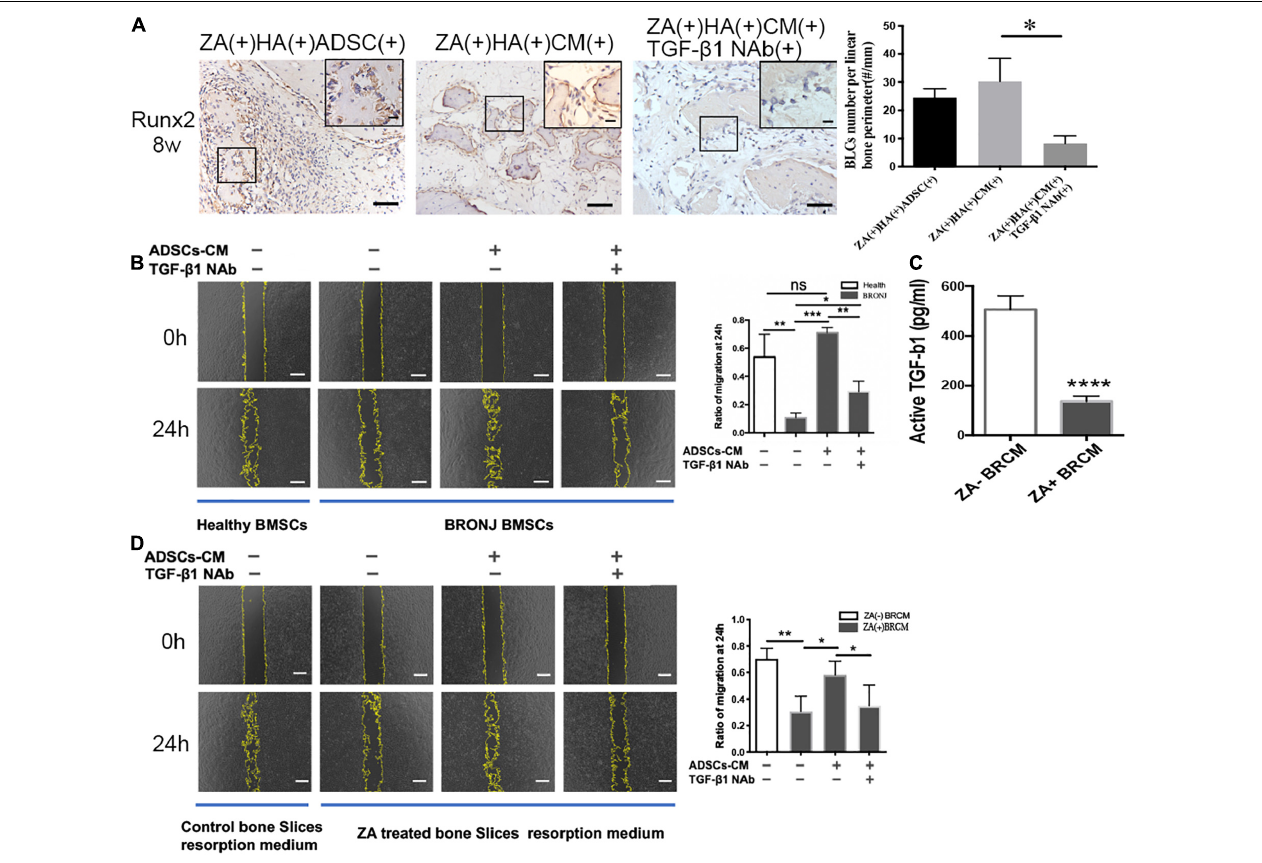
FIGURE 4 | Inhibition of TGF- β 1 attenuates Runx2-positive BLCs and BMSCs migration. (A) BLCs were evaluated by IHC of Runx-2 and quantification in alveolar sockets 8 weeks after tooth extraction in each group. The inset shows the boxed region magnified. Bar: 50 µ m, bar of magnified image: 20 µ m. (B) Migration of BMSCs from healthy individuals or BRONJ patients treated with ADSCs-CM without/with TGF- β 1 NAb and its quantification. Bar: 400 µ m. (C) TGF- β 1 concentration in bone resorption supernatant was evaluated by ELISA. (D) Cell migration of BMSCs from healthy donors using bone resorption medium collected from different bone slices (with or without ZA-treatment) and treated with ADSCs-CM with or without TGF- β 1 NAb and quantitative analysis. Osteoclastic resorption medium was collected from saline-treated bone slices control group. Bar: 400 µ m. ∗ p < 0.05, ∗∗ p < 0.01, ∗∗∗ p < 0.005, ∗∗∗∗ p <